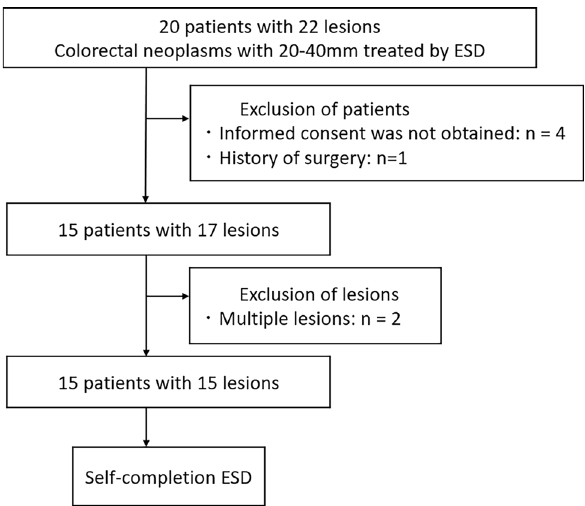
Figure 2. The flowchart of enrolled patients in this study. ESD, endoscopic submucosal dissection.